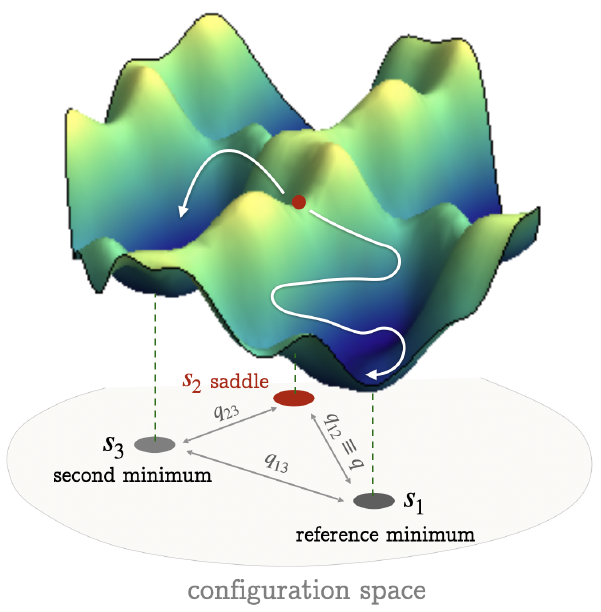
Figure 1: Pictorial representation of the landscape with a pair of local minima con- nected by a saddle s . The white lines represent the dynamical evolution of the 2 system conditioned to start from the saddle as an initial